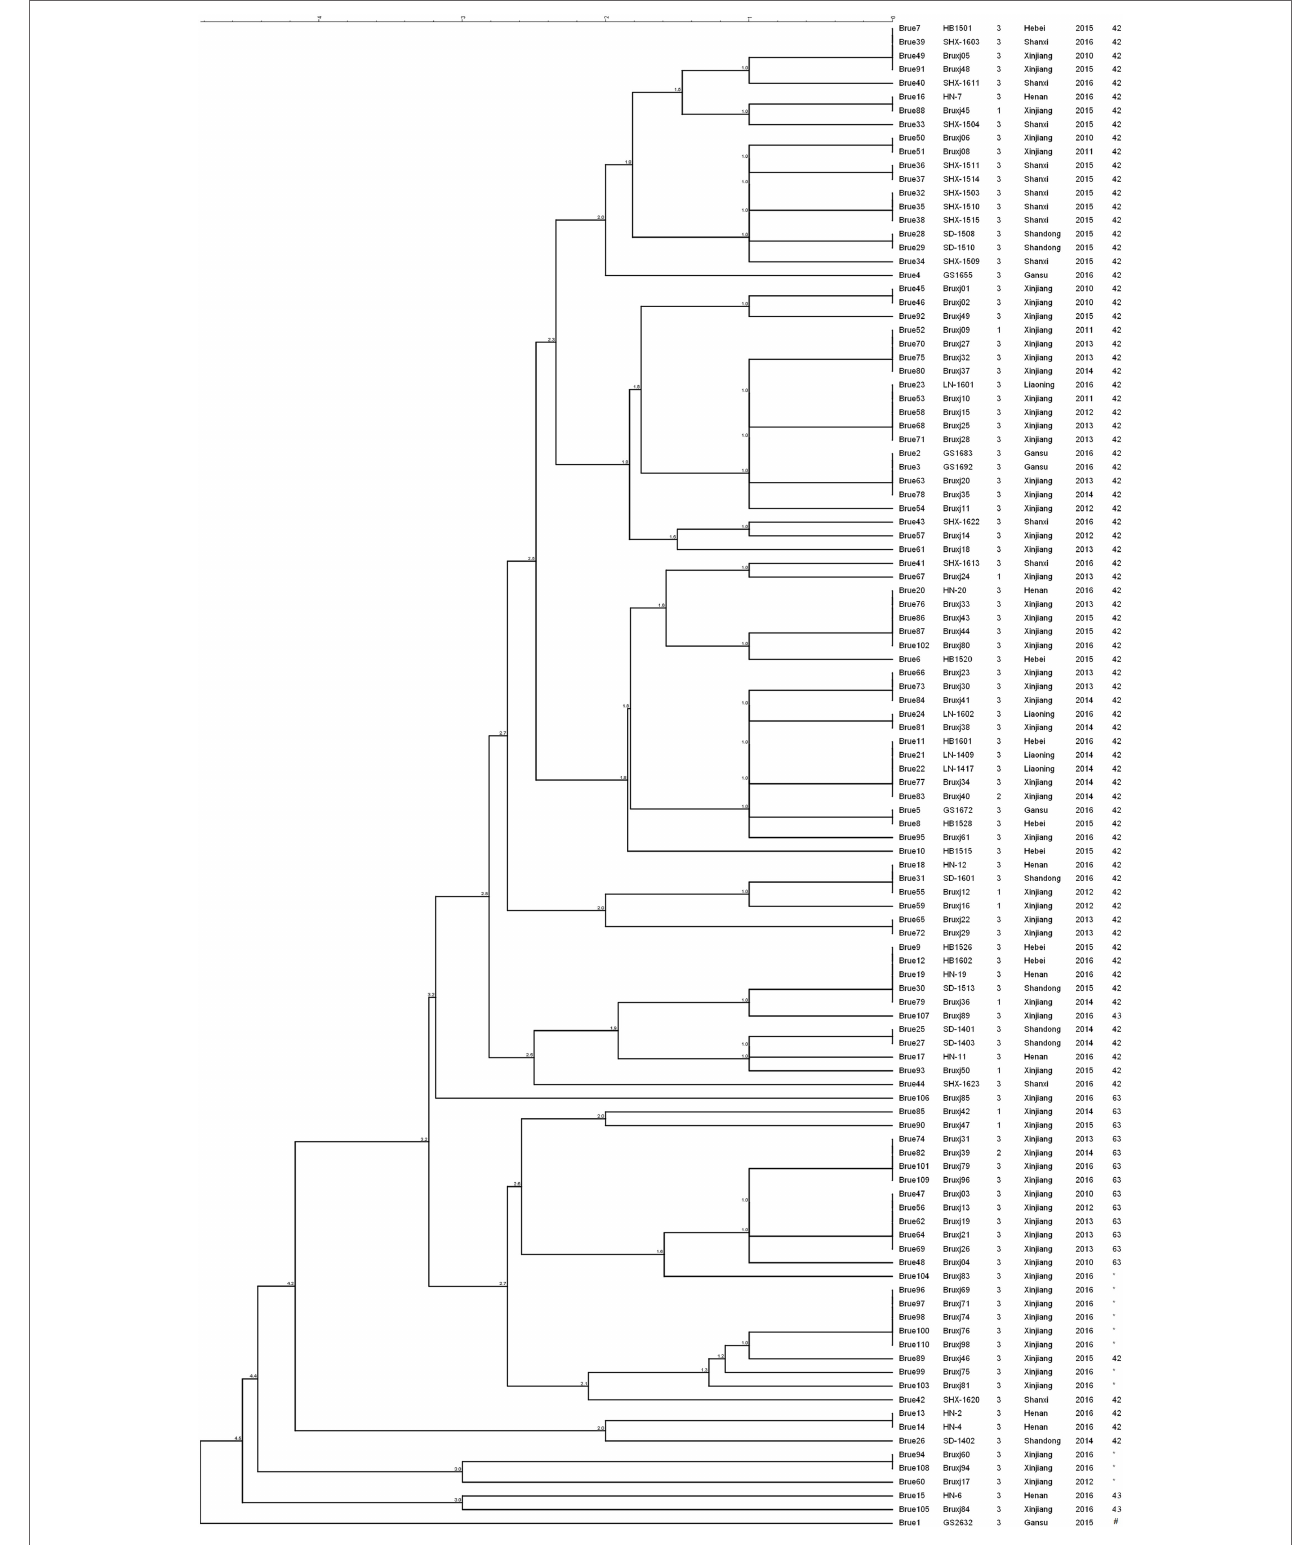
FigUre 1 | Clustering analysis of 110 Brucella melitensis isolated from China based on dataset of 16 variable-number tandem-repeats. In the columns, the following data are indicated: key, strain ID, biovar, isolation location, isolation date, and MLVA-8 genotype ID. * indicates the MLVA-8 genotype with the profile of 1-5-3-13-2-4-3-2; # indicates the newly detected MLVA-8 genotype of 1-5-3-14-2-2-3-2 in this study.